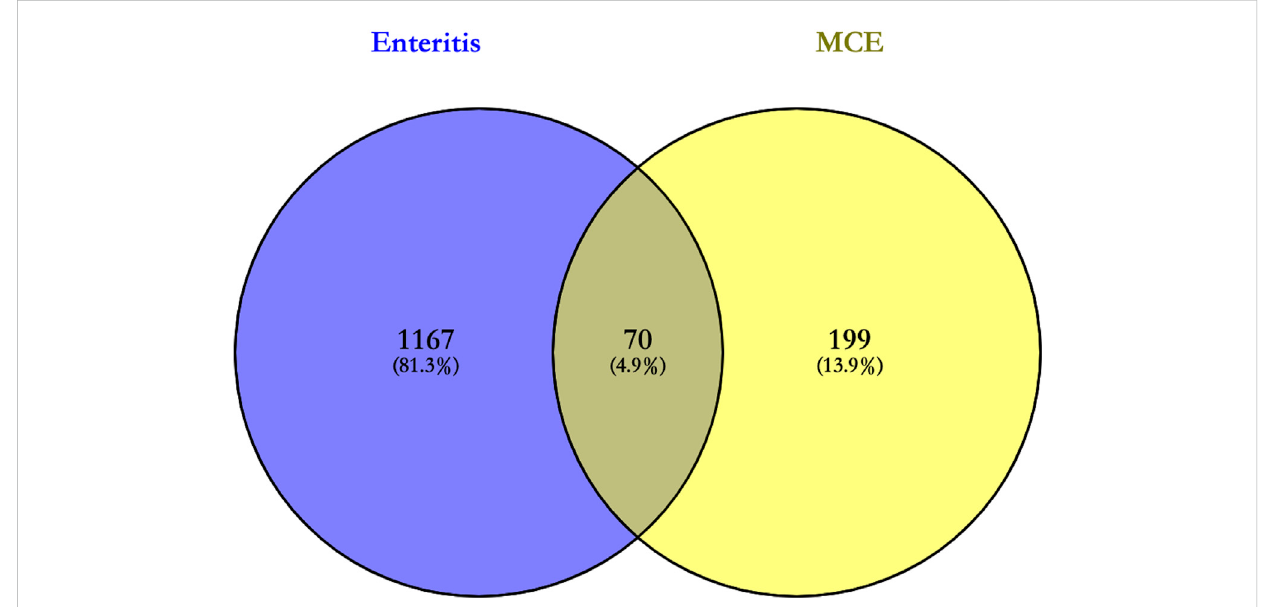
FIGURE 1 VenndiagramfortheintersectionoftargetsofenteritisandthefouractivecompoundsofMCE.Thepurplecolorontheleftistheenteritistarget,and the yellow color on the right is the target of the four active compounds of MCE; their intersection represents potential targets for the pharmacological effects of the four active compounds of MCE in the treatment of